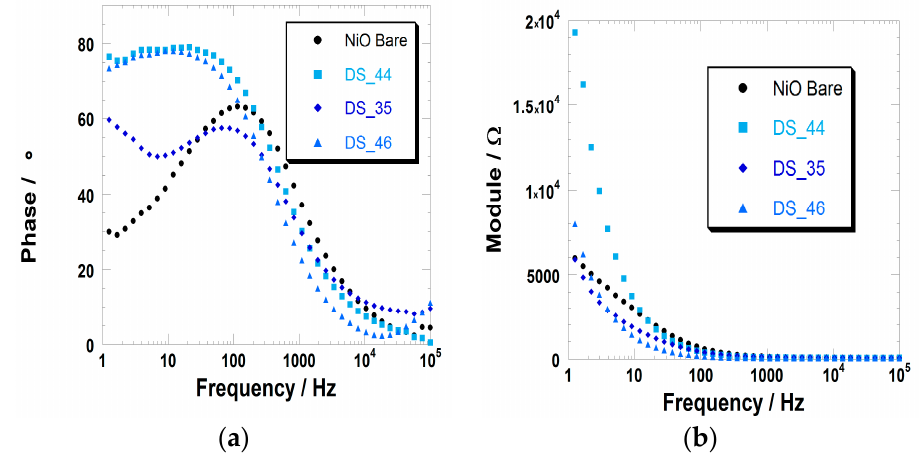
Figure 7. ( a ) Variation of the phase of the electrochemical impedance with the frequency of the potential stimulus for the cells with the bare, DS_35-, DS_44-, and DS_46-sensitized NiO as the working electrode; ( b ) Variation of the impedance modulus with the frequency of stimulus for the four cells analyzed in the left frame.